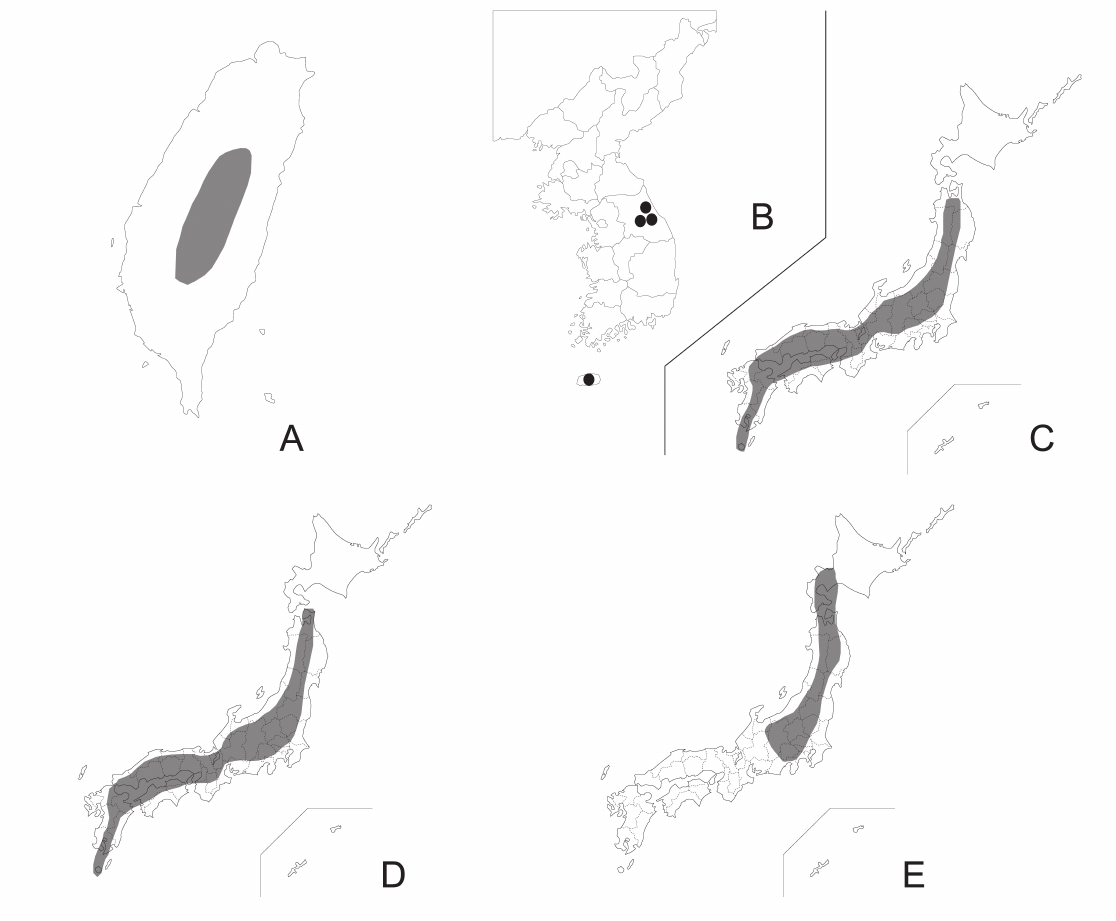
Fig. 12. distribution maps. A . Lasioglossum ( Dialictus ) atroglaucum (Strand, 1913) and L . ( D .) taiwanense Murao sp. nov. B–C . Lasioglossum ( Dialictus ) virideglaucum ebmer & Sakagami, 1994 (B in the Korean Peninsula, c in Japan). D . Lasioglossum ( Dialictus ) yamanei Murao et al ., 2006. E . Lasioglossum ( Dialictus ) negoroi Murao &